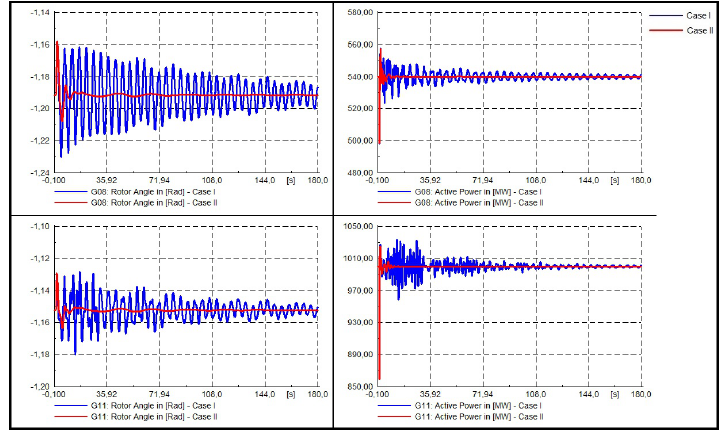
Figure 31. Rotor angle [rad] and Active Power [MW]-three phase fault at Line